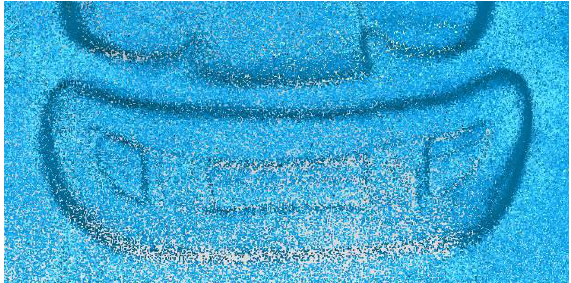
Figure 9. “Escultura 23”. Detail of Mantis mesh showing the sculpture’s